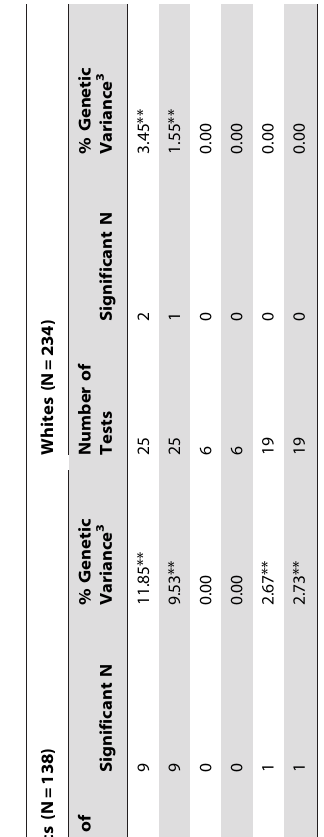
Table 5 presents the estimates of the genotype effects of SNP rs1053989 for Model A and Model B. The pattern of the size of the genotype effects and their statistical significance are essentially the same for models A and B, i.e., they are independent of whether BMI and parity and smoking are in the model. The estimates of genotype effects when Model B is considered that are presented in Table 5 are plotted in Figure 1, where the relative frequencies of the three genotypes are included. The A allele explains a large and statistically significant dominant effect on the decrease in birth weight in Blacks (A/ A =3173, A/C= 3075, C/C = 3378) and Hispanics (A/A = 3323, A/C =3224, C/C = 3552) and a recessive effect in Whites (A/ A =3291, A/C =3436, C/C = 3442). Those Black and Hispanic mothers carrying the A allele had infants whose birth weight was on average 254 and 302 grams, respectively, less than infants having C/C mothers. Those White mothers homozygous for the A allele had infants who were on average 148 grams less than those infants having A/C and C/C mothers. The relative frequency of the A allele in Black mothers was significantly greater than in Hispanic and White mothers (Figure 1). Black mothers carried the A allele (relative frequency = 0.703) approximately twice as often as the Hispanic (relative frequency =0.356) and White mothers (relative frequency = 0.402).